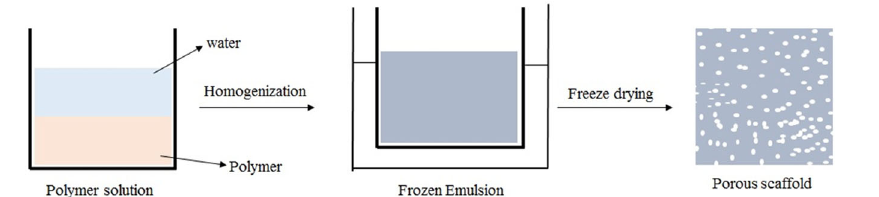
dispersed phase is water, quickly cooling the emulsion to catch in the liquid phase construction, and eliminating the solvent and water by freeze-drying Fig. 4 Scheme composite scaffold by thermal induced phase separa- tion method (TIPS) for scaffolds designing consists of quenching the polymer solution under the solvent ’ s freezing point (Tk) and enforcing liquid – liquid separation to shape two phases: a polymer-rich phase and a polymer-poor phase. The polymer-rich phase solidi fi es and